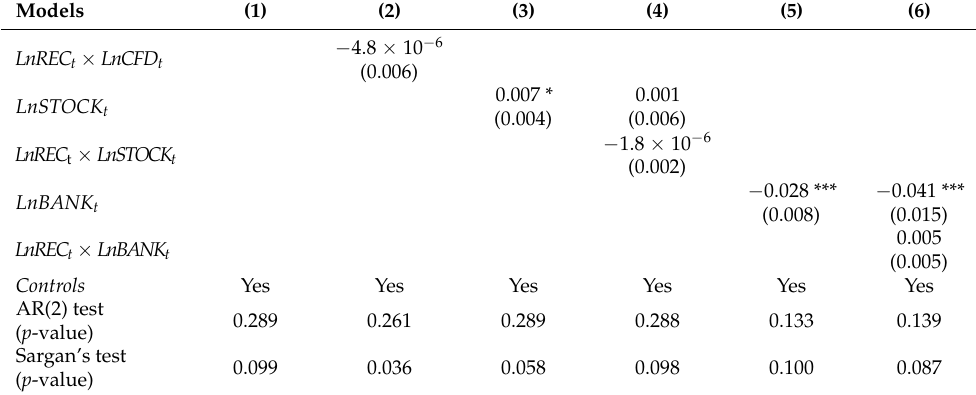
Table A2. Cont. Models